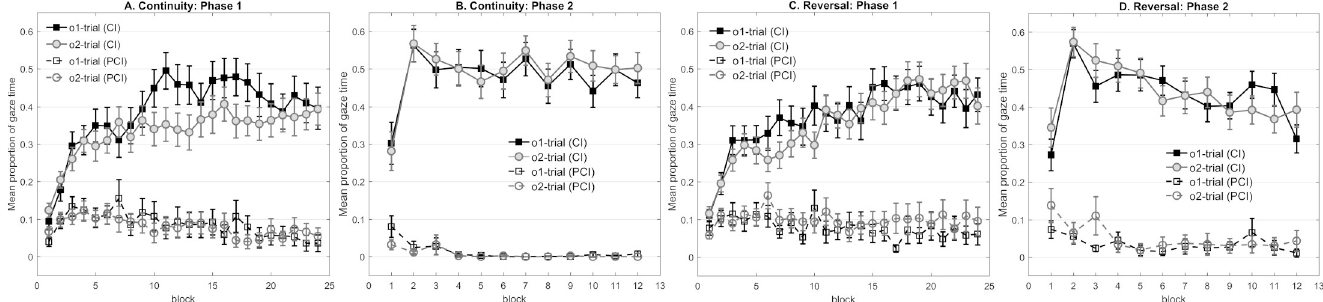
Fig 7. Panel A to D represent the mean proportion of gaze time in Experiment 5 that participants looked at the correct outcome’s cave during the cue (CI) and the pre-cue interval (PCI) respectively in each phase. (A) Mean gaze time of Group Continuity across the 24 blocks in Phase 1. (B) Mean gaze time of Group Continuity across the 12 blocks in Phase 2. (C) Mean gaze time of Group Reversal across the 24 blocks in Phase 1. (D) Mean gaze time of Group Reversal across the 12 blocks in Phase 2. Note that gaze time of both groups in responses to cue C in Phase 1 was averaged within each block.